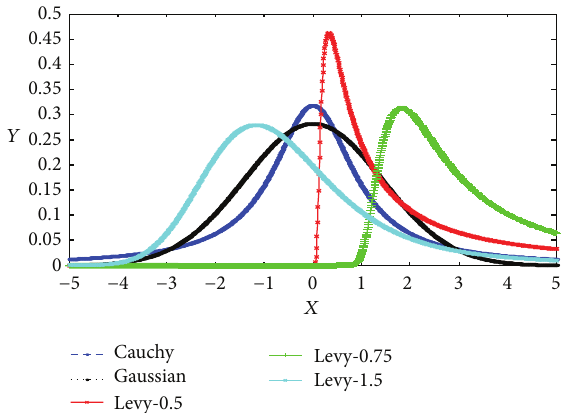
Figure 1: The PDF curve of the three distributions.